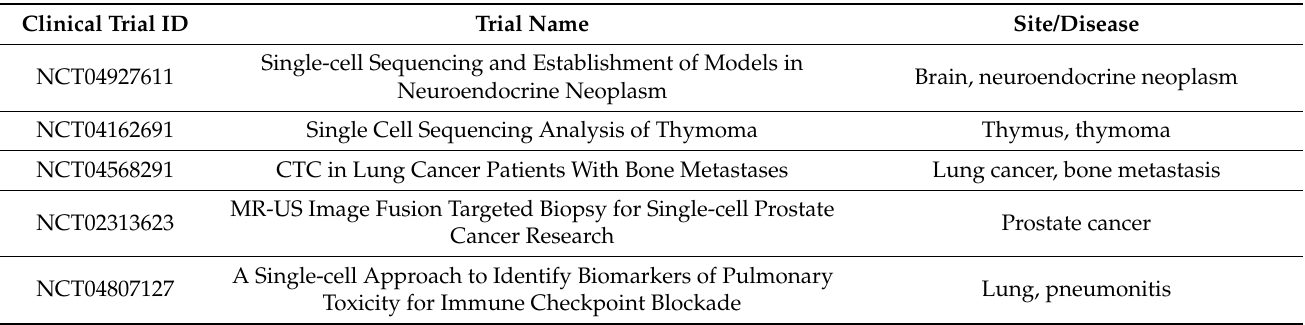
Table 2. Ongoing cancer-related clinical trials utilizing single-cell